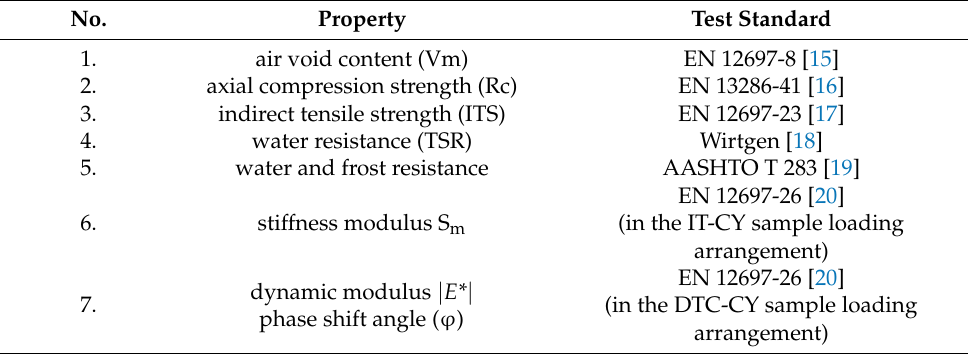
Table 11. Testing methods used for the assessment of the FB-RCM